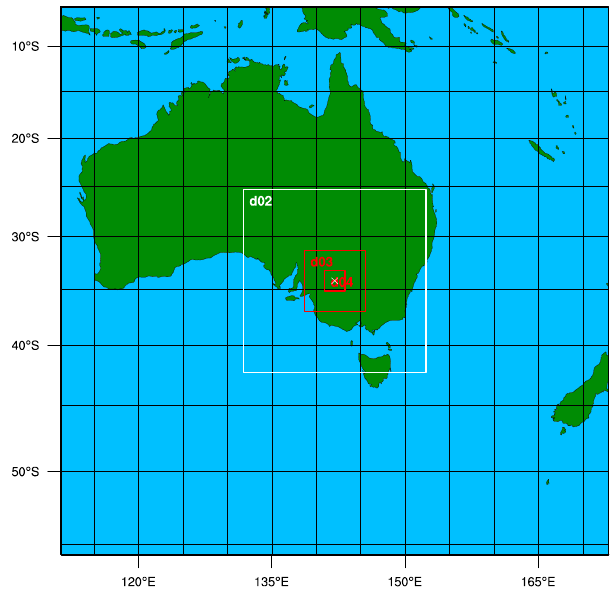
Table 2. Overview of WRF model domain configuration.